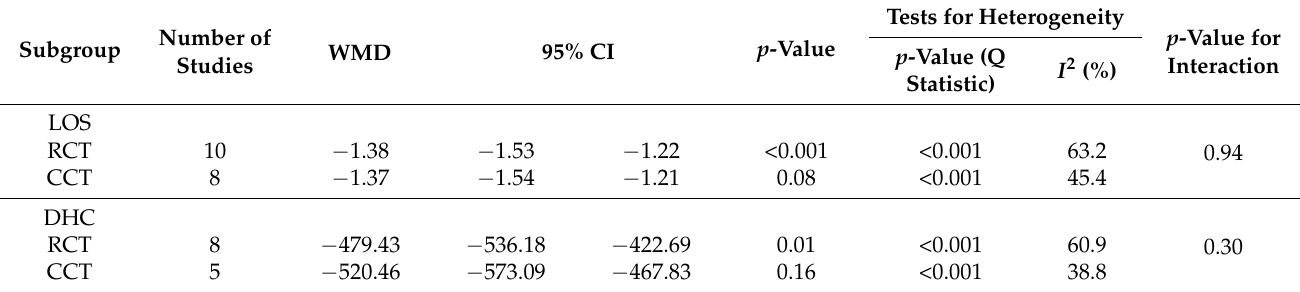
Table 2. Results of subgroups analyses and tests of